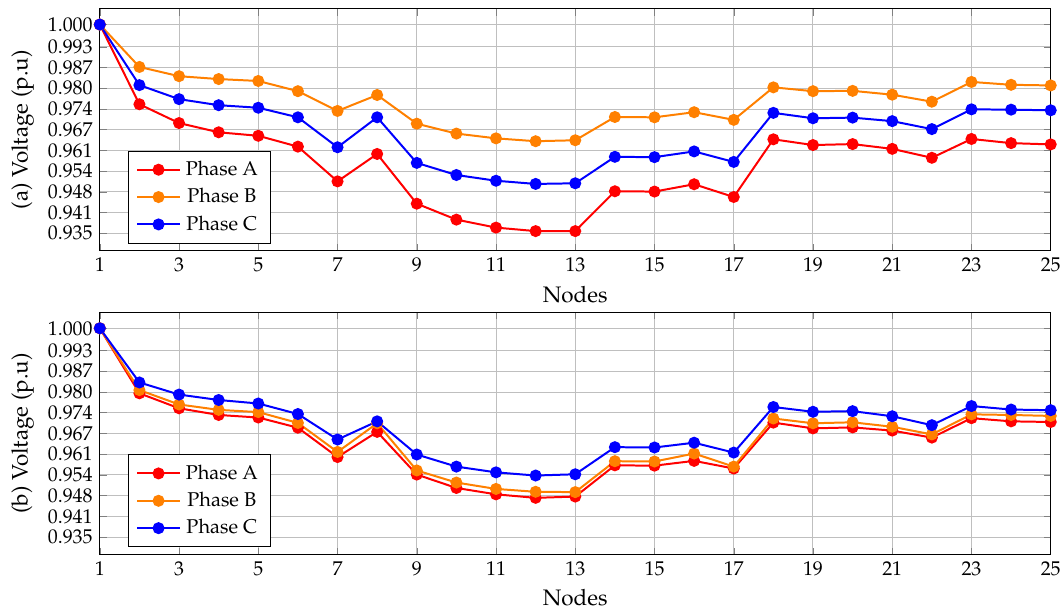
Figure 15. Voltage profiles for the 25-node test system: ( a ) modified benchmark case and ( b ) proposed